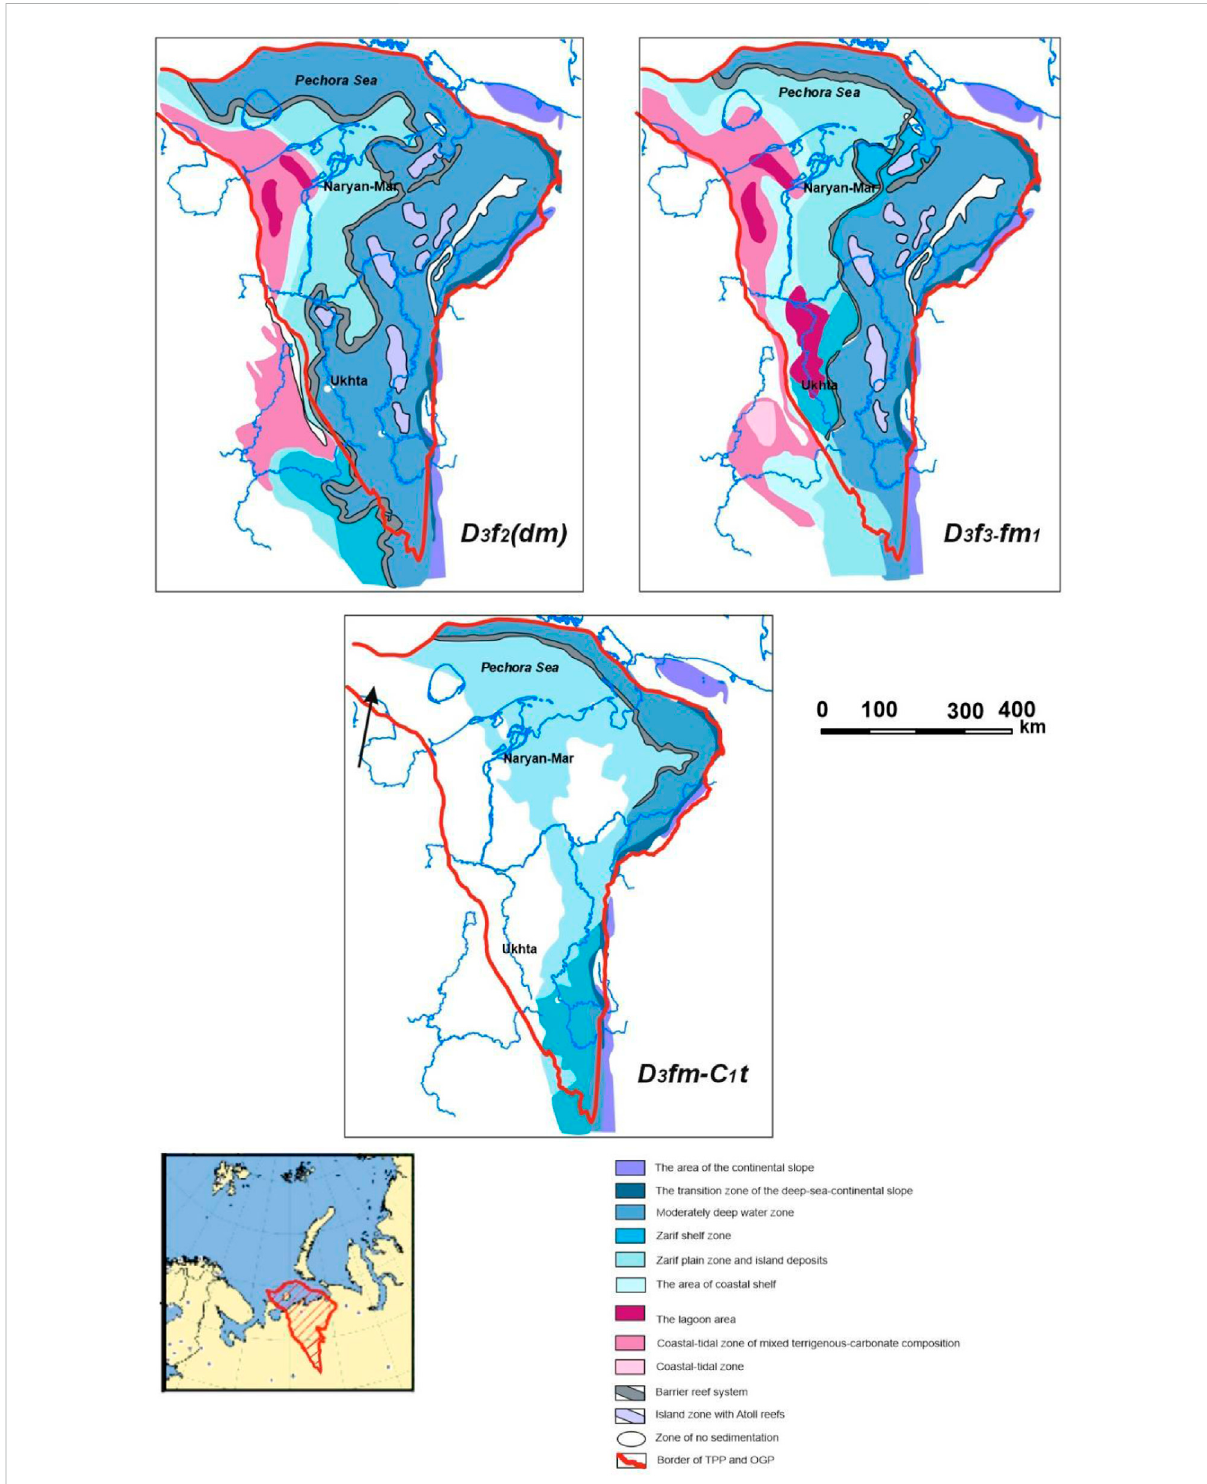
FIGURE 2 Lithological-facies map of the development of the Domanik and Domanikoid deposits of Middle-Frasnian, Late-Frasnian and Famennian- Tournaisian stages in the Timan-Pechora OGP (Prischepa and Averyanova, 2017).